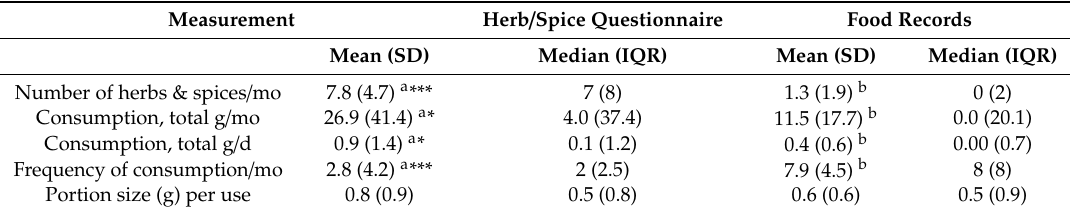
Table 3. Mean and median herb and spice intakes collected by the herb / spice questionnaire and food records.